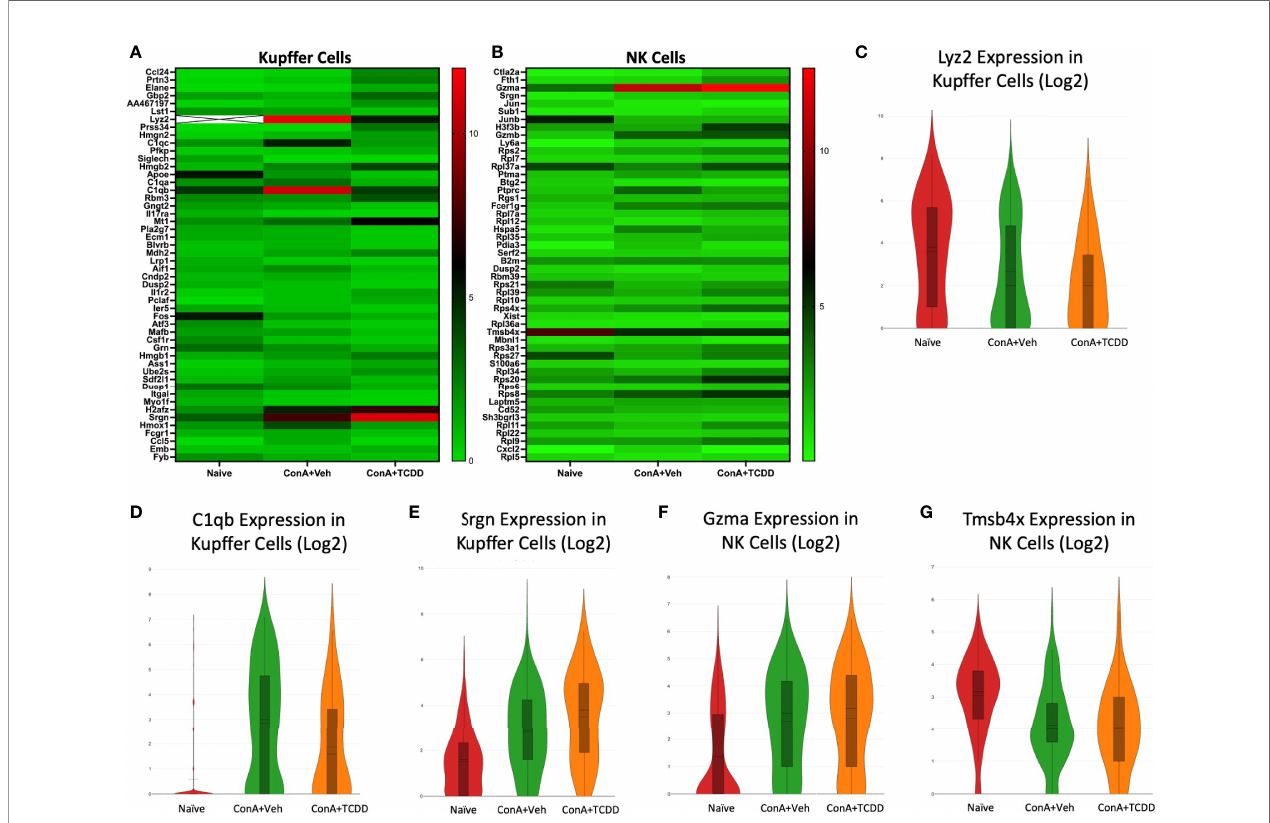
FIGURE 5 | Gene expression changes observed in Kupffer cells and NK cells upon ConA exposure and subsequent TCDD treatment. C57/BL6 mice were injected with ConA followed by vehicle or TCDD 1 hour later as described in Figure 1 legend. Liver mononuclear cells were isolated and scRNA-seq was performed as described in Methods. Heatmaps consisting of the top 50 differential genes per treatment were generated using Loupe Browser. Heatmaps of differentially expressed genes from (A) Kupffer cells and (B) NK cells. In panel (A) , the X marked with some genes represents an expression level over 20. (C – G) Violin plot of Log2 expression of target